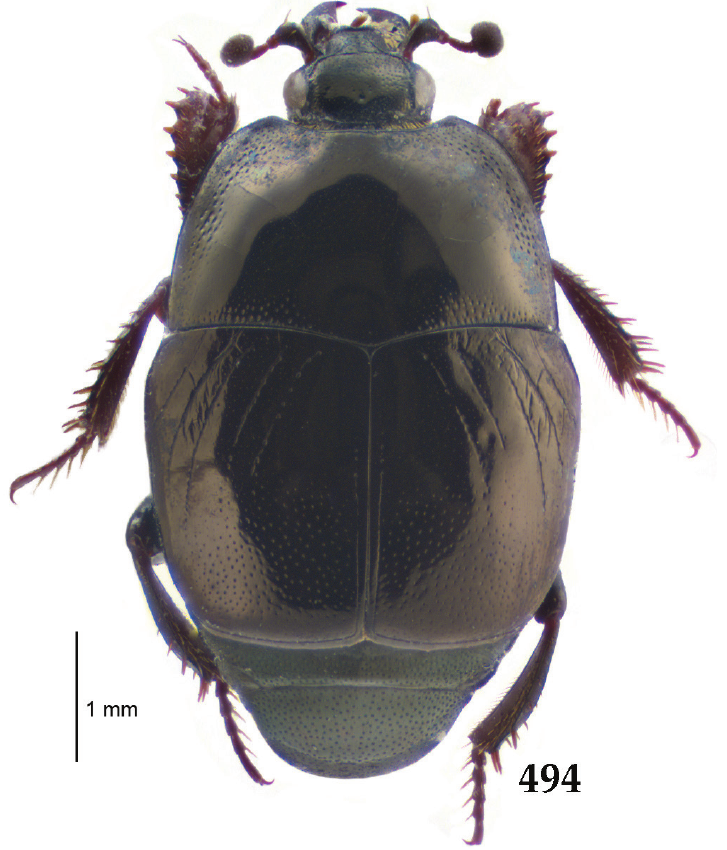
Figure 494. Saprinus ( Saprinus ) pacificus sp. n. habitus, dorsal